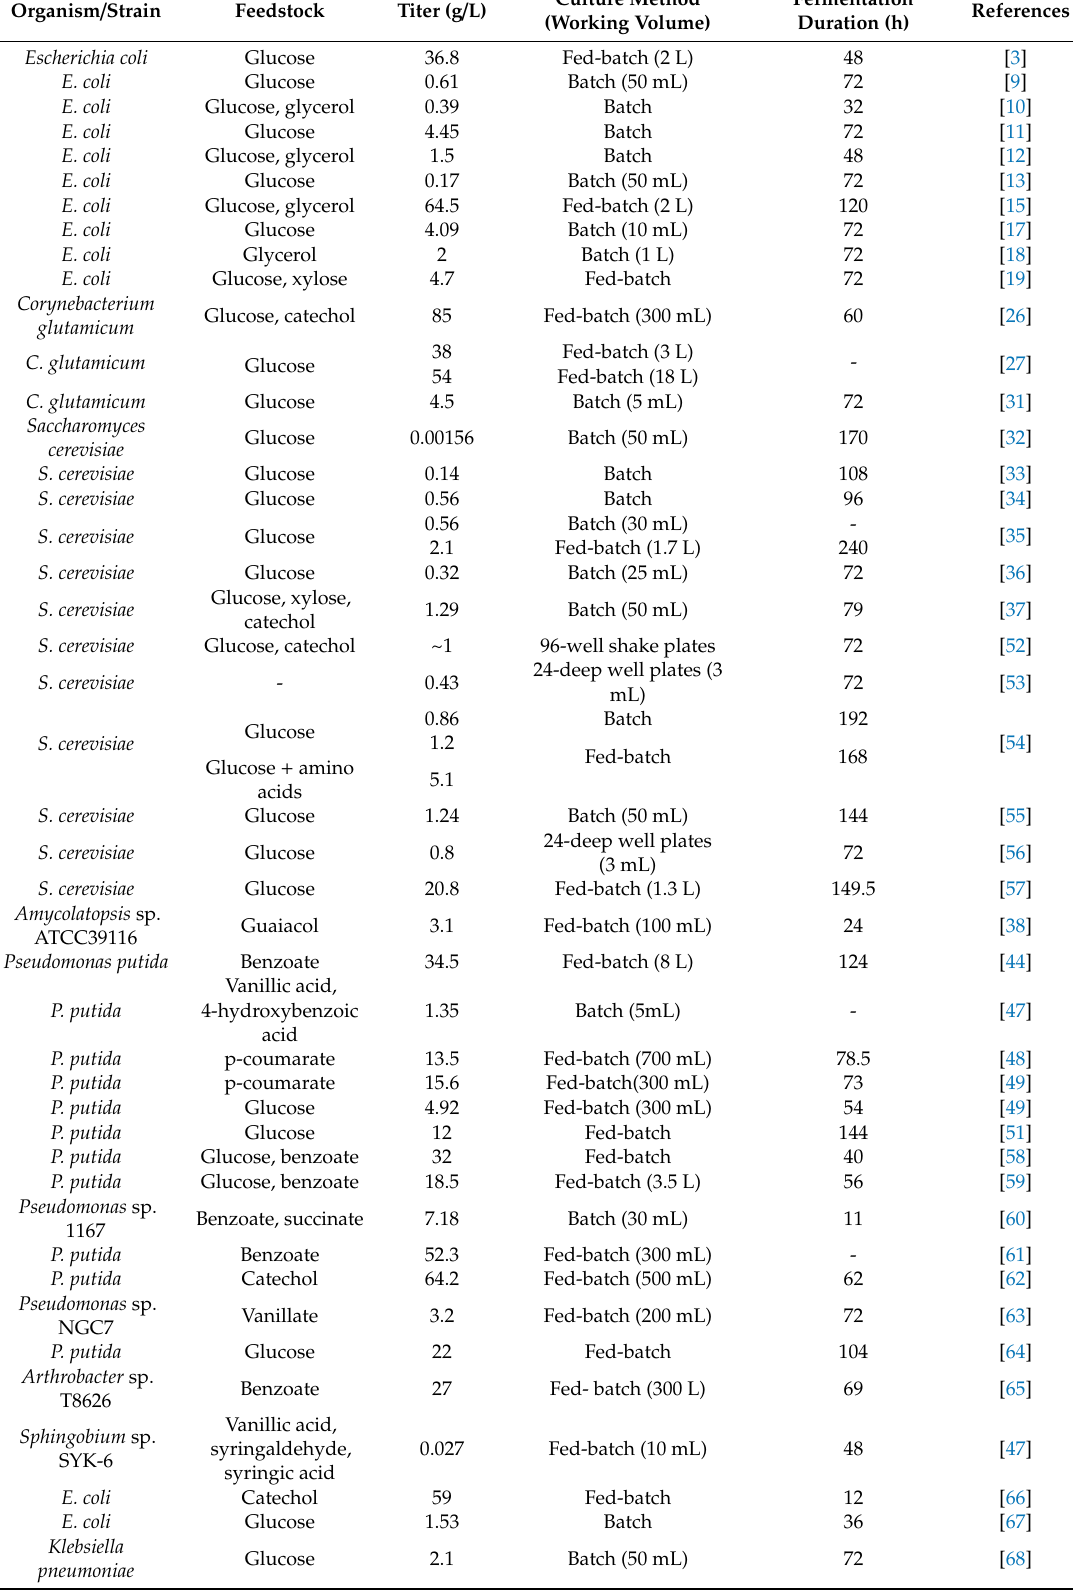
Table 1. List of engineered microbial strains for MA biosynthesis. Organism /